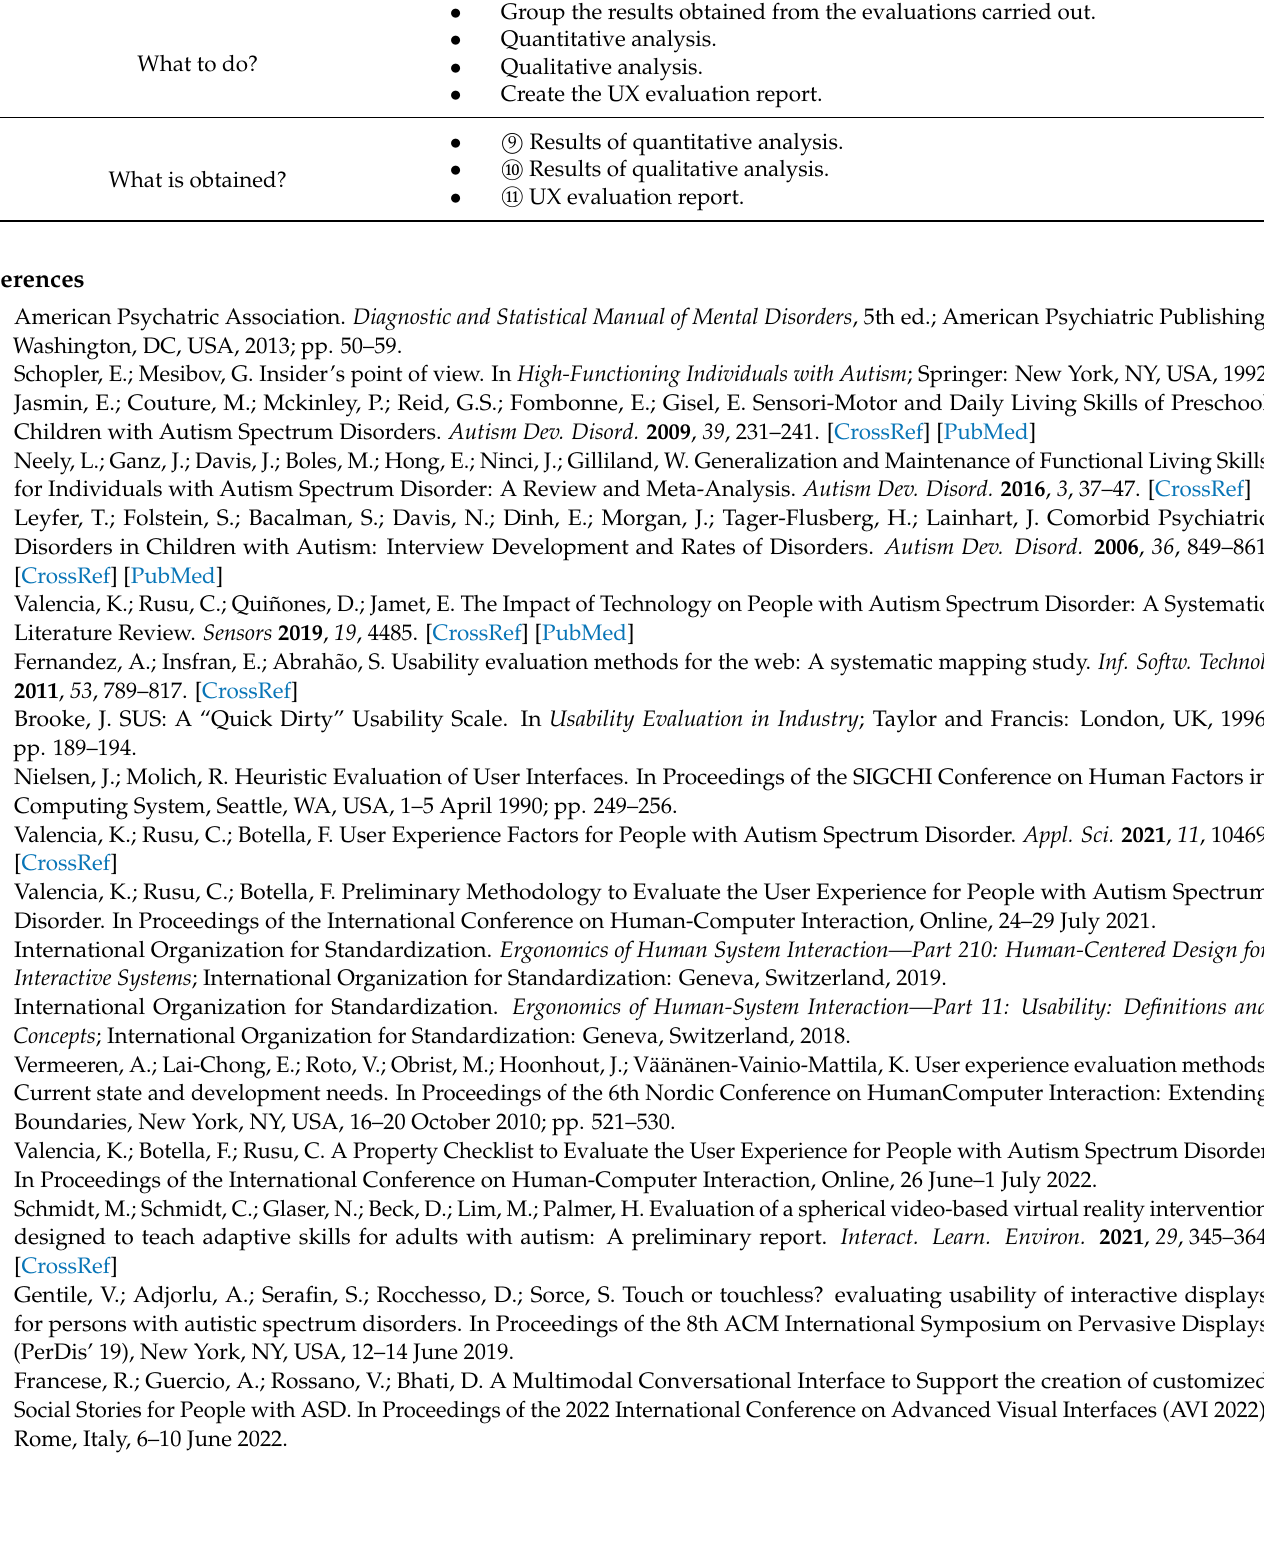
Table A14. Results Analysis Stage Specification. S3: Results Analysis Stage Analysis and report of the results found.